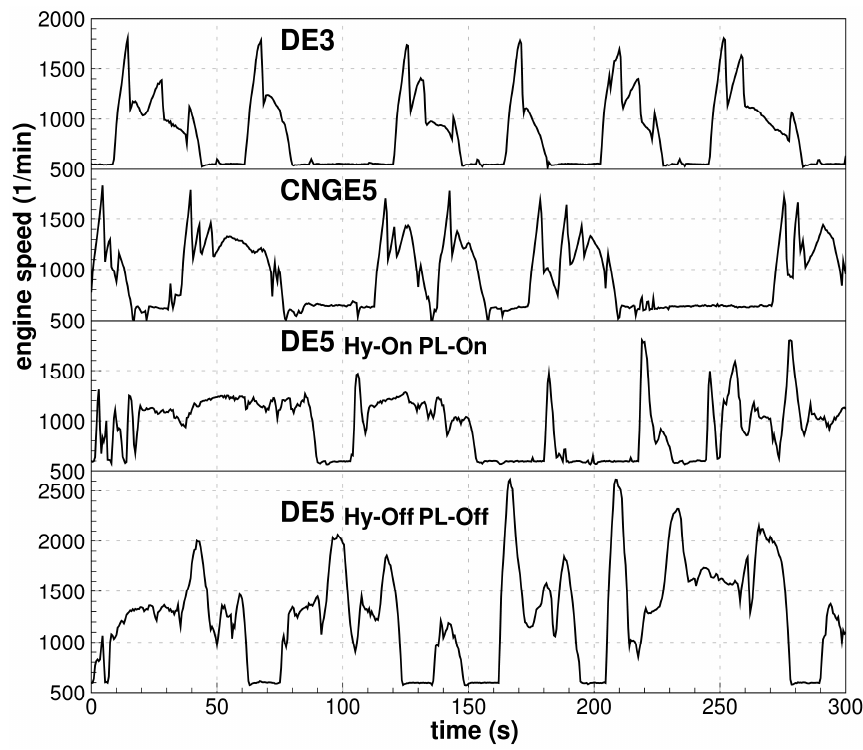
Figure 5. Engine speed vs time measured on the DE3 bus, CNGE5 bus, DE5 bus in hybrid mode with power limiter on and in non-hybrid mode with power limiter off.